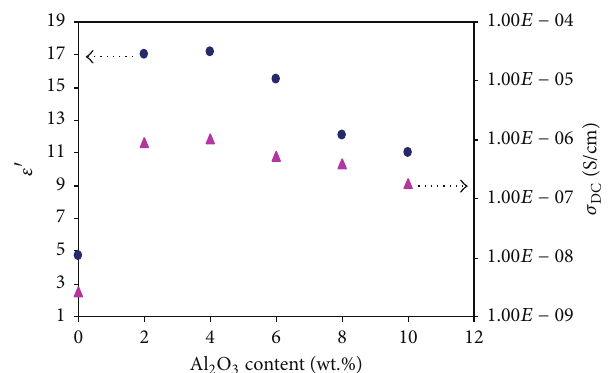
Figure 13: Dependence of bulk dielectric constant ( 𝜀 󸀠 at 1MHz) and DC conductivity of chitosan: LiTf (90: 10) on Al 2 O 3 concentration.